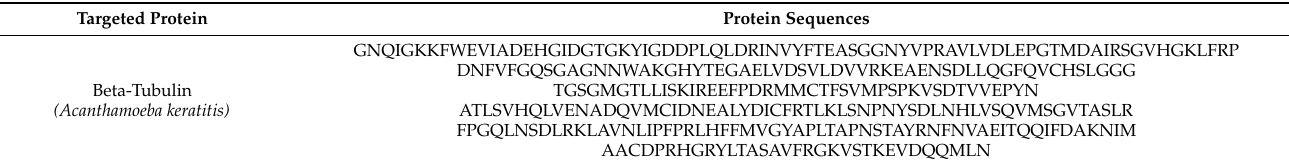
Table 6. Fasta format of the beta-tubulin sequence from NCBI data. Targeted Protein Protein Sequences Beta-Tubulin (Acanthamoeba